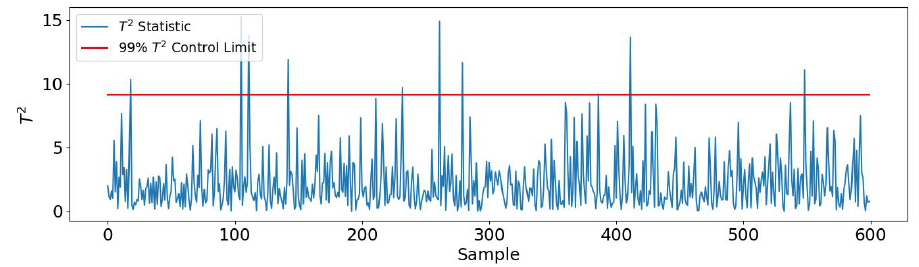
Figure 10. Monitoring results of common cointegration analysis.